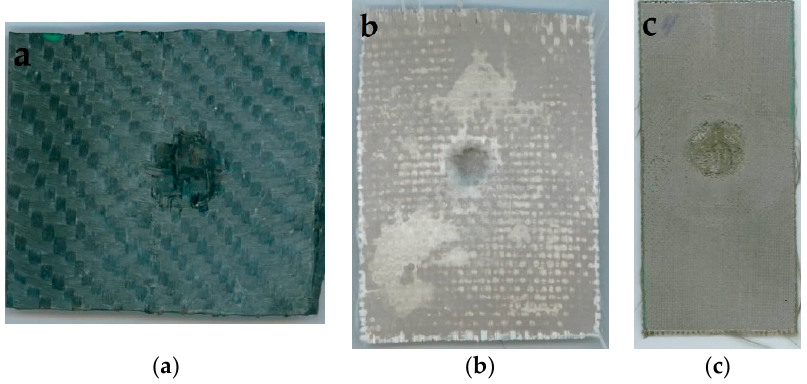
Figure 2. ( a ) Carbon ( b ) E-glass ( c ) Basalt fiber reinforced geopolymer composite after impact